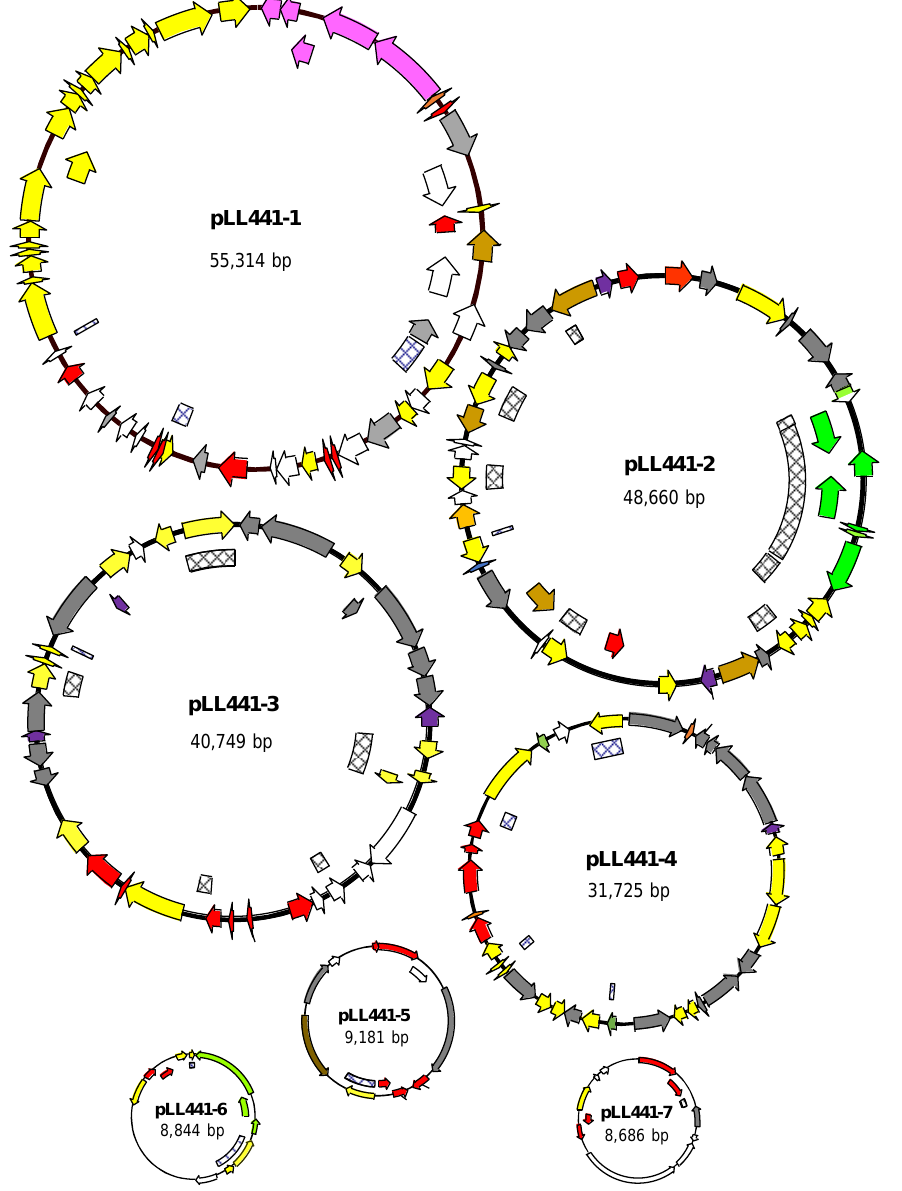
Figure 1. Genetic maps of the seven plasmids of L. plantarum LL441 (pLL441-1 to pLL441-7). Arrows indicate the position, direction, and length of the ORFs. Color key: red, genes encoding plasmid replicating and maintenance functions; yellow, IS elements and genes involved in mobilization; green, genes involved in the carbohydrate metabolism; purple, plantaricin C-associated genes; brown, genes encoding other or unknown functions; white, hypothetical ORFs. Stripped boxes indicate the sequences are repeated on the genome. Sizes of the plasmids are relative but not drawn to scale.